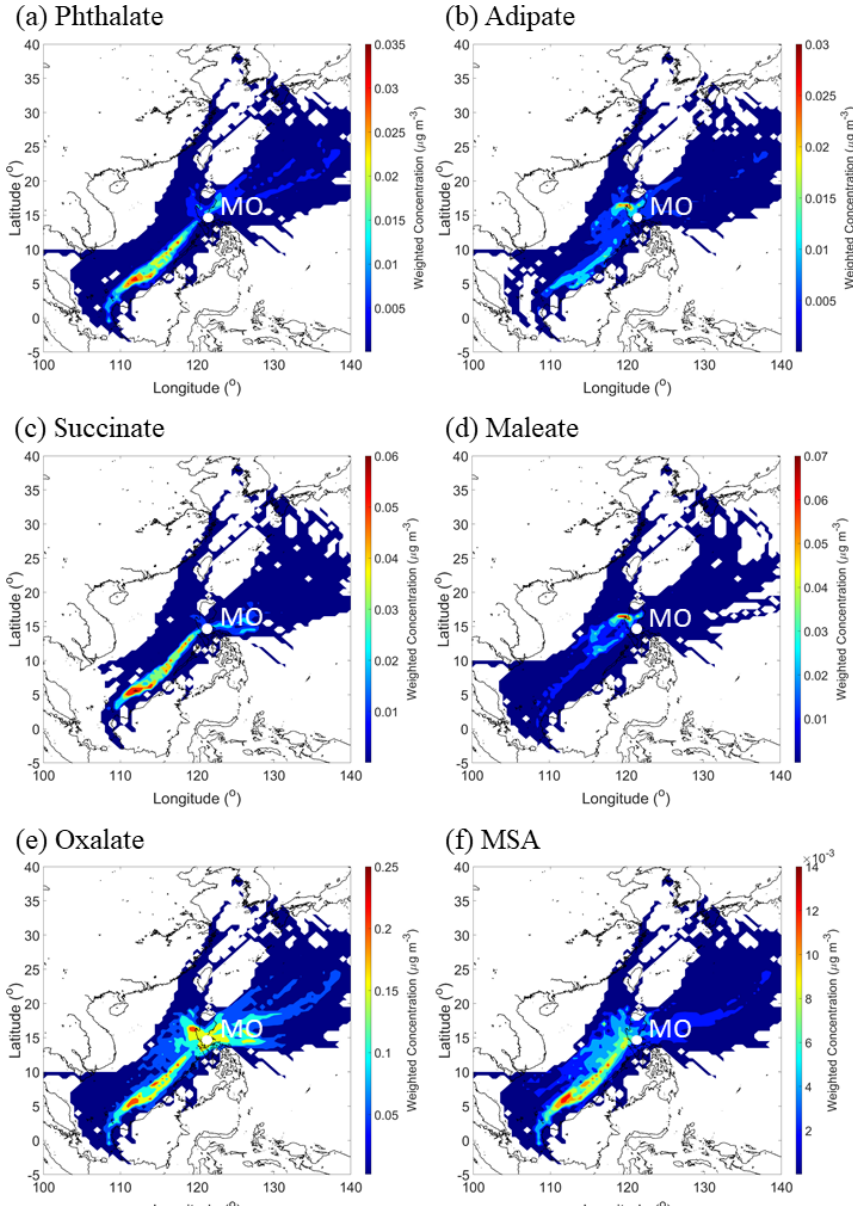
Figure 12. CWT maps of (a–e) individual organic acids and (f) MSA over the entire sampling period. These results are based on all MOUDI sizes (0.056–18µm). Maps showing the seasonal results for each organic acid and MSA are shown in the Supplement (Figs.